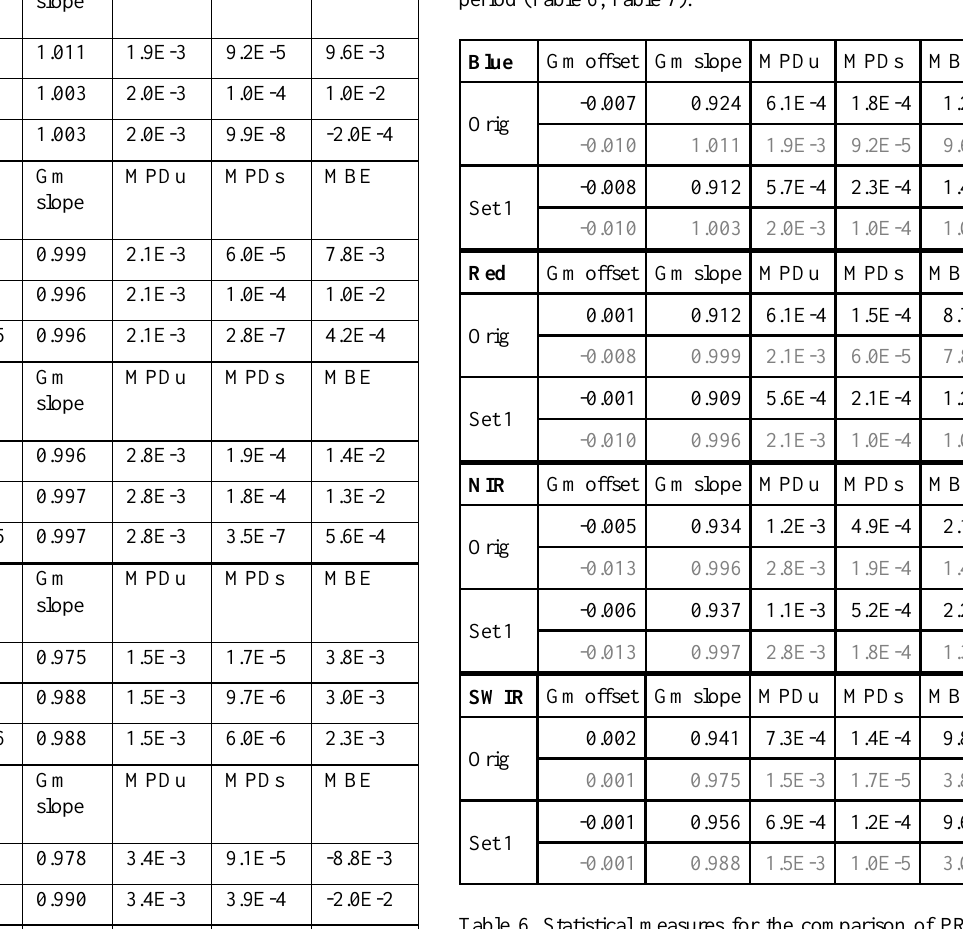
Table 6. Statistical measures for the comparison of PROBA-V (X) and VGT2 (Y) TOC reflectance composites for the original PROBA-V data and the Set1 PROBA-V data